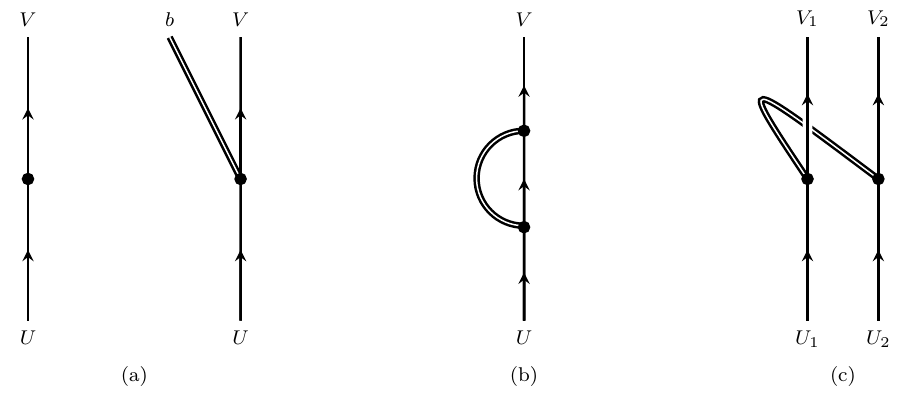
Figure 22 . Construction of C Z 2 : (a) A morphism can involve a b line or not. Notice that the 0 direction of b line is irrelevant as it is equal to its dual. (b) Composition of two morphisms involving a b line is obtained by using the canonical map from b (cid:10) b to identity to join the b lines. (c) Tensor product of two morphisms involving a b line is twisted by a half-braiding of b across V 1